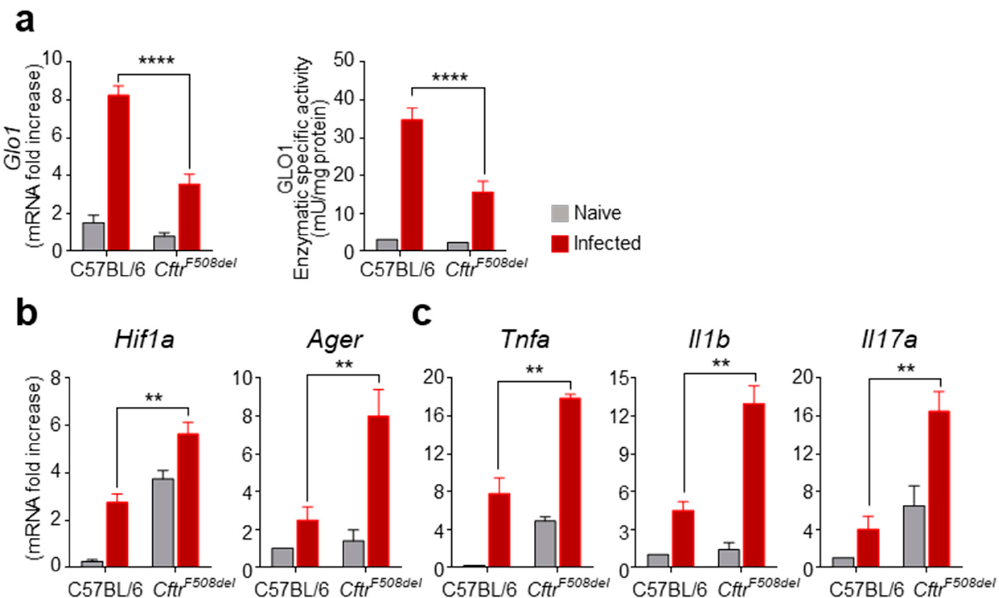
Figure 1. GLO1 expression and activity in CF mice. C57BL/6 and Cftr F508del mice were infected intranasally with live A. fumigatus conidia and evaluated for the levels of ( a ) GLO1 mRNA and enzyme specific activity, and for the levels of ( b ) Hif1a , Ager , and ( c ) Tnfa , Il1b , Il17a in the lung after 6 days of infection. Gene expression was performed by RT-PCR and enzyme-specific activity by an enzymatic assay as described in Section 2. Data are presented as mean ± SD of three independent experiments. Each in vivo experiment includes four mice per group. ** p < 0.01, **** p < 0.0001, infected C57BL/6 vs. infected Cftr F508del .